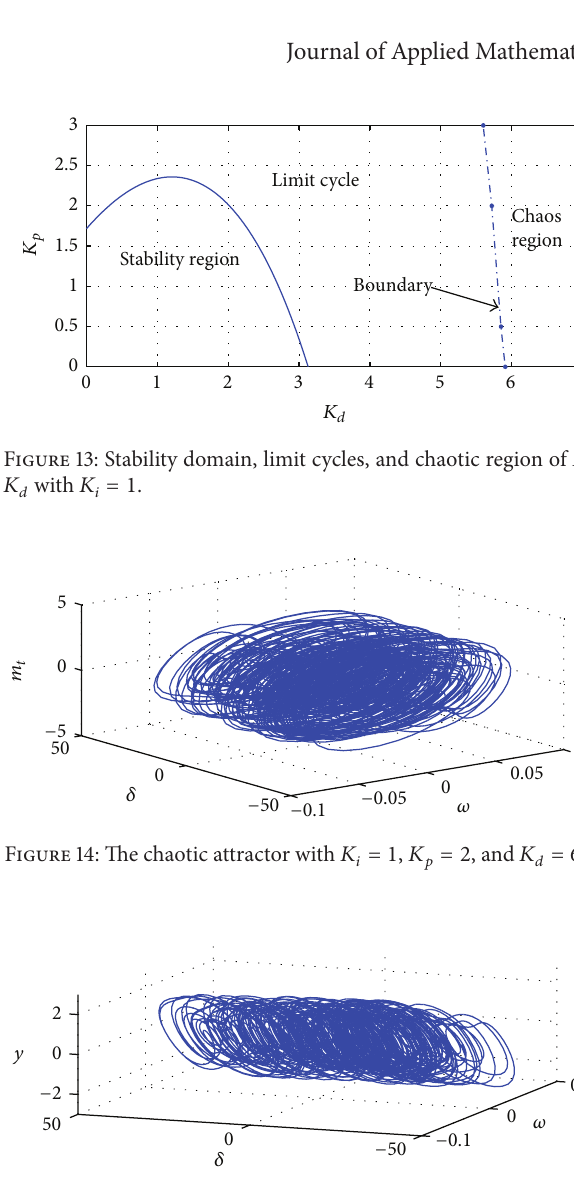
Figure 15: The chaotic attractor with 𝐾 𝑖 = 1 , 𝐾 𝑝 = 2 , and 𝐾 𝑑 = 6.5